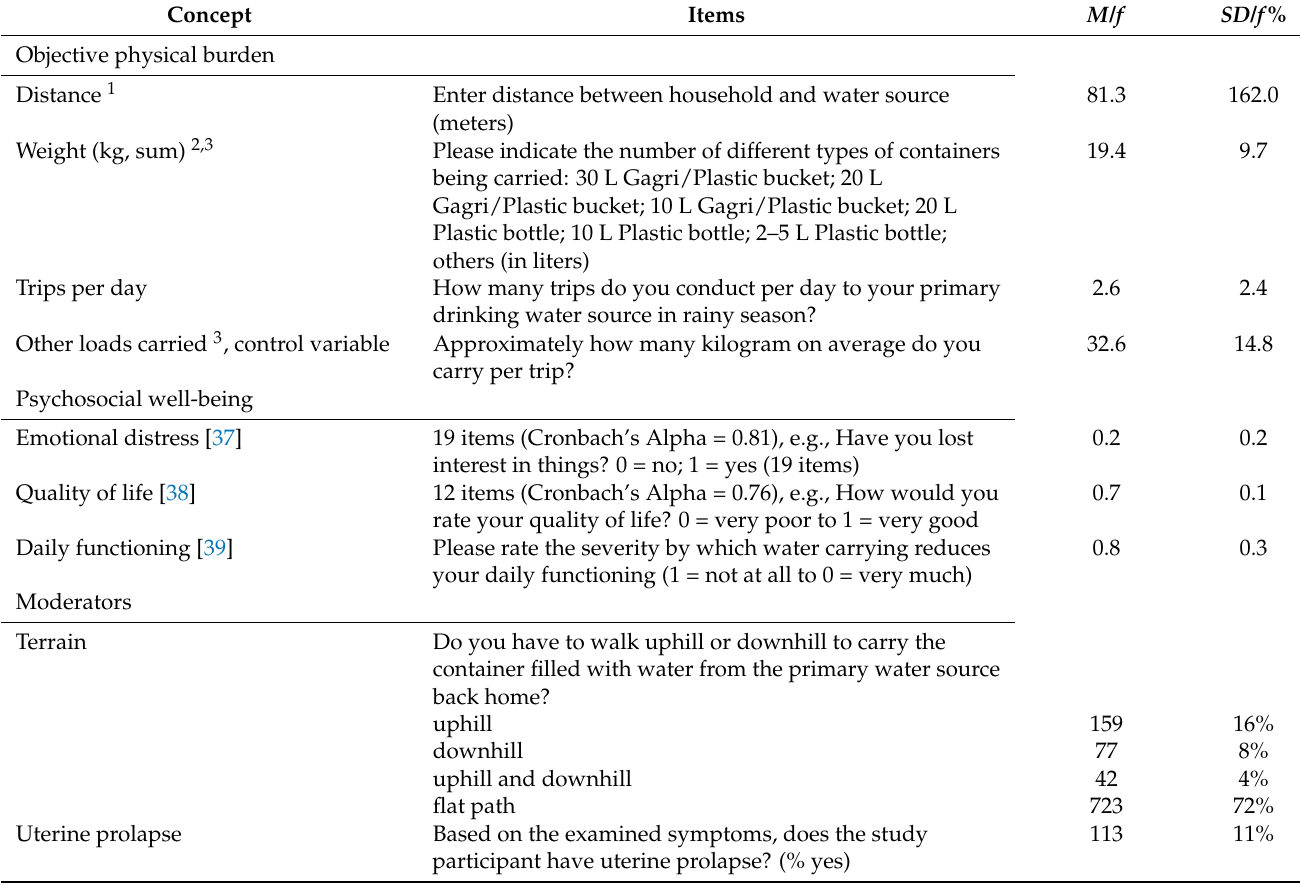
Table 1. Sample items and descriptive